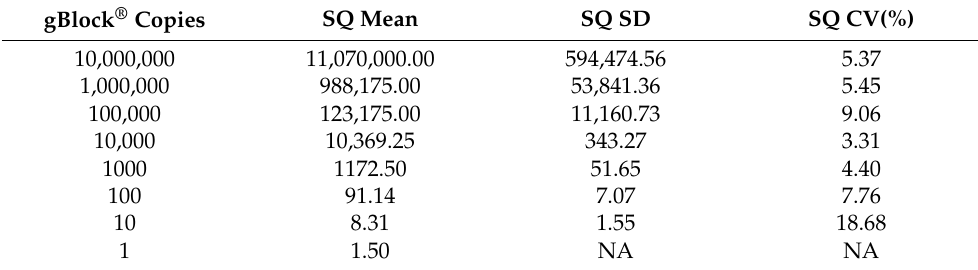
Table 3. Yokenella qPCR limit of quantification (LOQ). Assay LOQ was evaluated by running